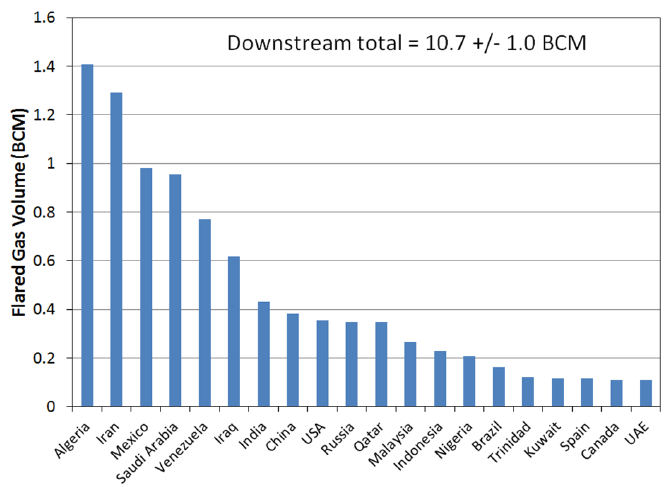
Figure 12. Top 20 countries for downstream gas flaring in 2012.